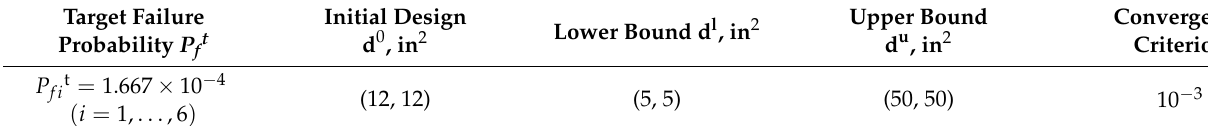
Table 8. Target failure probability and parameters for design variables and optimization.